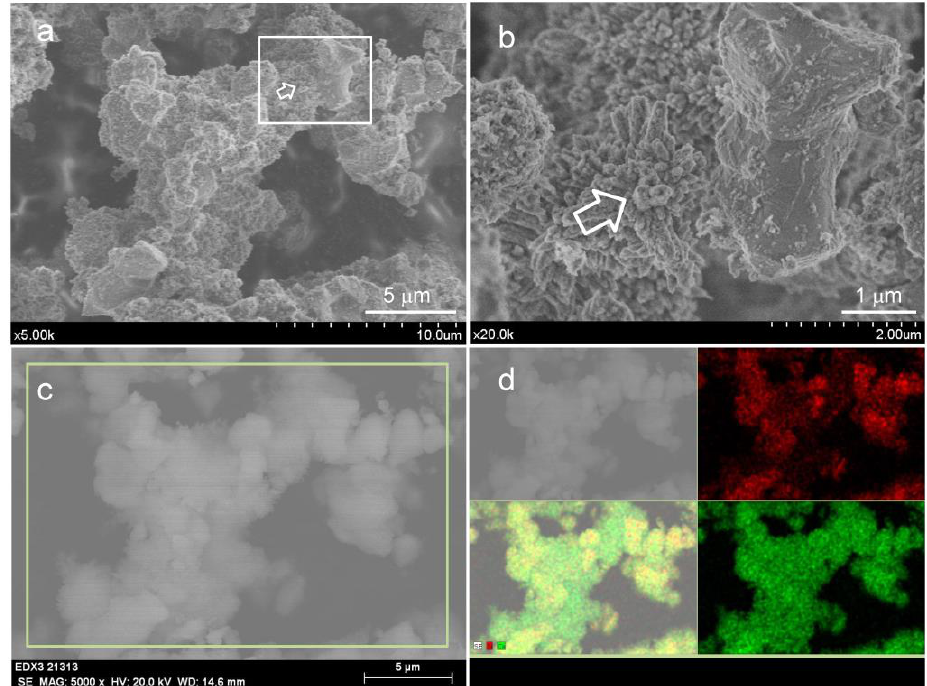
Figure 8. FEG-SEM observations and EDX analysis of ACaNO-HNO (EPT): ( a ) low-magnification secondary electron (SE) image using 2 kV; ( b ) higher magnification corresponding to the area marked with the white square in image ( a ), white arrow in images ( a , b ) points to a characteristic aggregate formed by the EPT treatment; ( c ) low-magnification SE image of the area displayed in ( a ) using 20 kV; ( d ) EDX analysis of image ( c ) showing Si (red), Ca (green), and merged (yellow) element-distribution analysis.